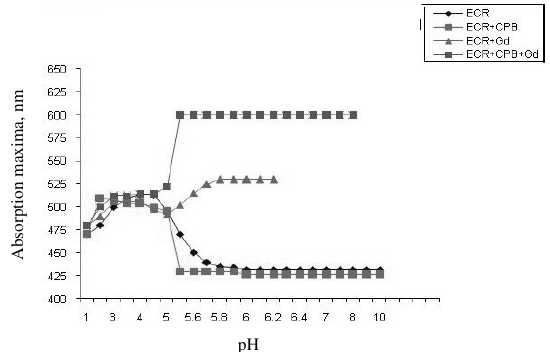
Figure 2. Variation of absorption maxima with pH for ECR and Gd(III).